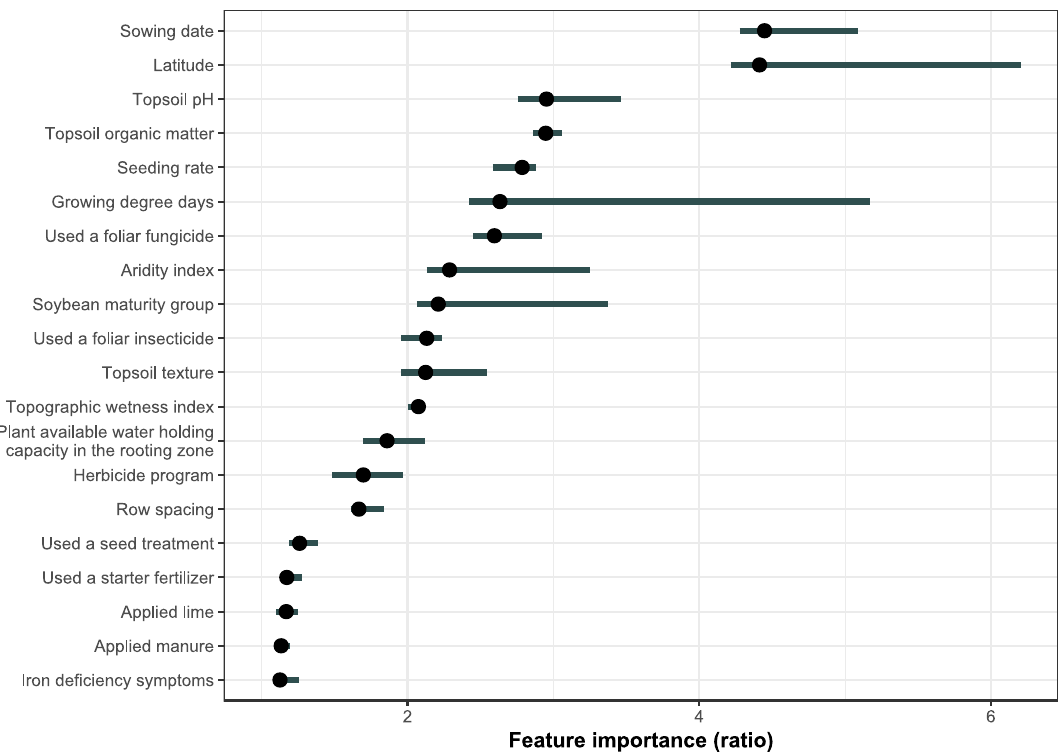
Fig. S6 online complements Fig. 3 by summarizing the Shapley φ values in another visual format. The overall mean predicted yield for the unsprayed ( s 1 c 2 ) fields was slightly higher (by 0.1 t/ha) than that for the sprayed ( s 1 c 1 ) fields (Supplementary Fig. S6 online). This difference may have been driven by the higher variability in yields among the two cohorts (particularly for TEDs 403603, 602303, 403703, and 303603), or underlying dif- ferences in other management factors. Also, the number of sprayed fields in each of these four TEDs was at the target sampling boundary of 20 fields per TED (Supplementary Table S2 online). The Shapley φ values for fungicide use were well-separated among the four cohorts of fields of s 2 (Fig. 4, Sup- plementary Table S1 online). The fields within s 2 were selected across the entire dataset and not by TED mem- bership. The lowest-yielding fields ( s 2 c 2 & s 2 c 4 ) were all below the global yield average, whereas the converse was true of the highest-yielding fields ( s 2 c 1 & s 2 c 3 ). Among the lowest-yielding fields, foliar fungicides were mainly associated with a positive, but less than 0.2 t/ha, effect on yield ( s 2 c 2 ), and other factors were responsible for dropping a field’s yield to below the global average. Amongst the highest-yielding fields ( s 2 c 1 ), foliar fungicides